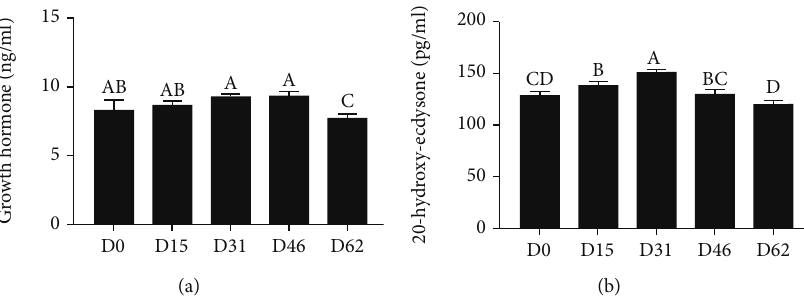
Figure 3: The content of growth hormone (a) and 20-hydroxyecdysone (b) in the serum of female E. sinensis in rice-crab culture systems at di ff erent developmental periods. A,B,C,D Mean values within a row unlike superscript letters were signi fi cantly di ff erent ( P < 0 : 05 ). Note: D0: sample data of July 15; D15: sample data of July 30; D31: sample data of August 15; D46: sample data of August 30; D62: sample data of September 15. The data are represented as the mean ± standard deviation ( n = 3 ). Di ff erent letters above the columns represent signi fi cant di ff erences observed between various treatments ( P < 0 : 05 ).